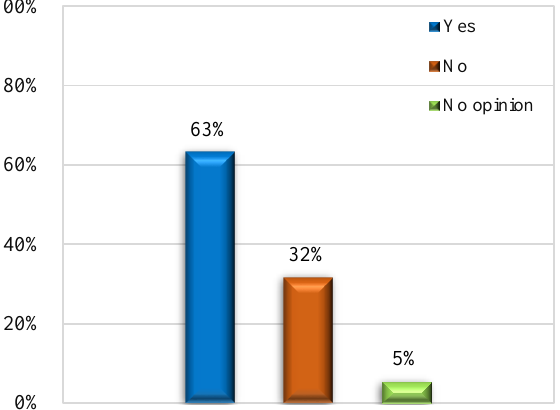
Figure 12. Comparison of combined results regarding shortage of competence in wooden frames considered by ERs and UERs.